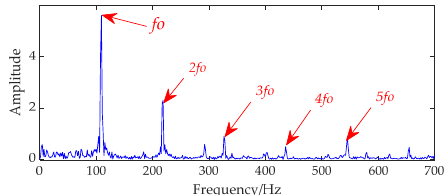
Figure 18. Envelope spectrum of mode 1.